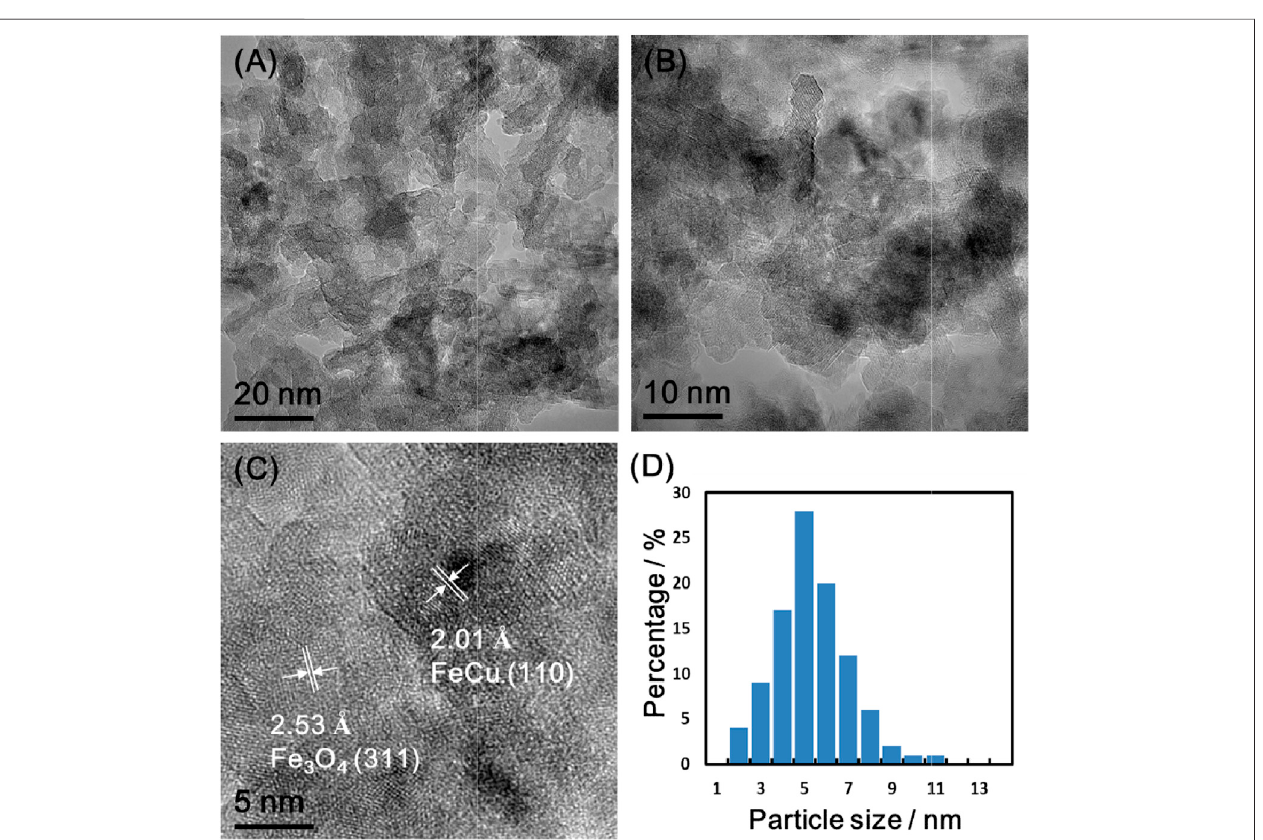
Frontiers in Chemical Engineering |